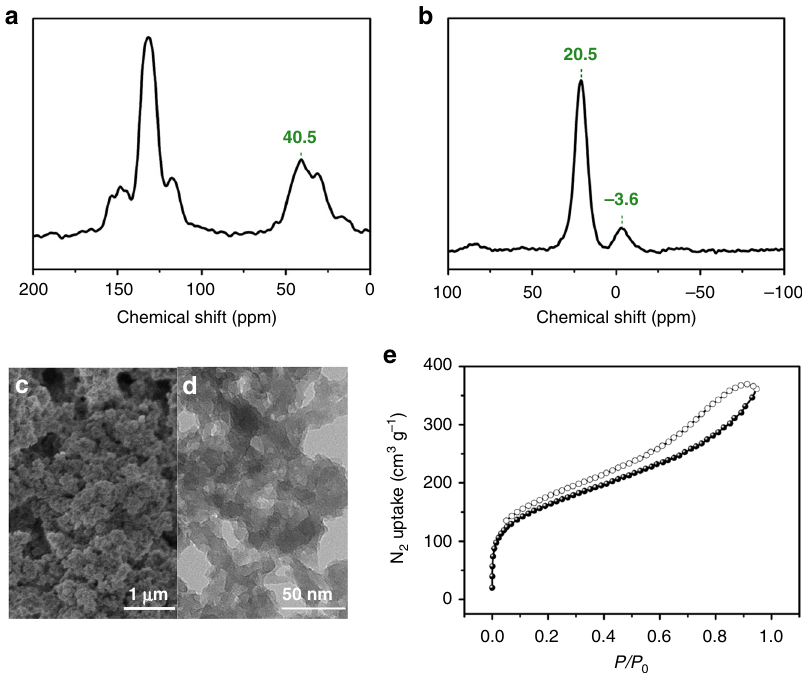
Fig. 2 Characterization of PSA-PPh 3 . ( a ) Solid-state 13 C NMR, ( b ) solid-state 31 P NMR, ( c ) SEM image, ( d ) TEM image, ( e ) N 2 sorption isotherms. Source data are provided as a Source Data fi